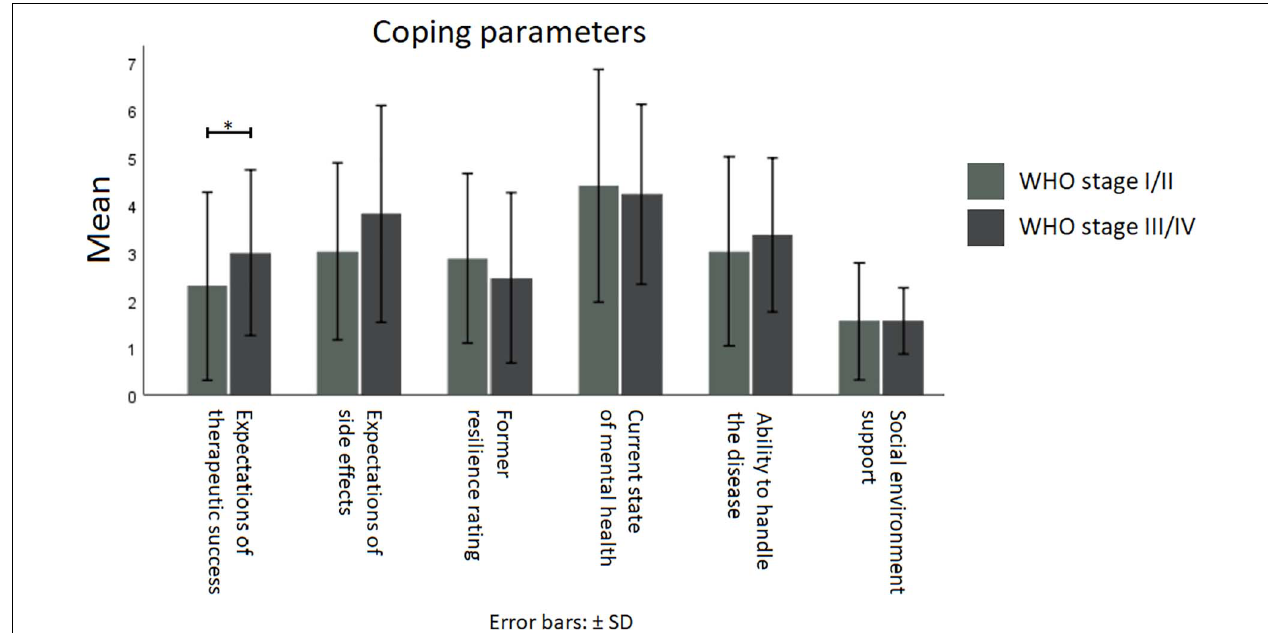
FIGURE 1 | Means of coping parameters for WHO stages I/II (light gray) vs. stages III/IV (dark gray). Kruskal-Wallis test showed no differences between lower and higher WHO stages, except for the expectations of therapeutic success ( H = 4.873, p ≤ 0.050, N = 66). * p ≤ 0.05.